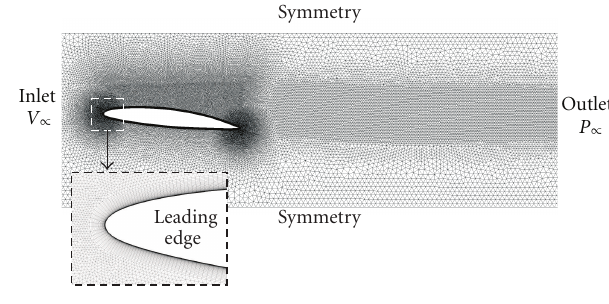
Figure 2: 2D fluid mesh and boundary conditions.